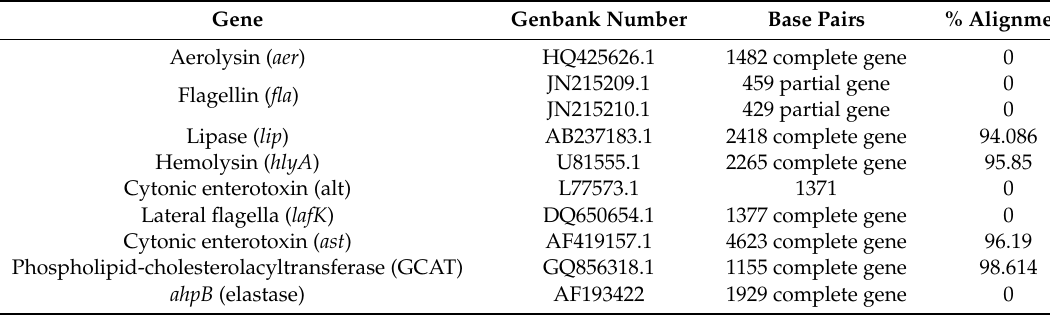
Table 1. Alignment of Aeromonas hydrophila CVM861 with Genbank sequences for Aeromonas- specific virulence